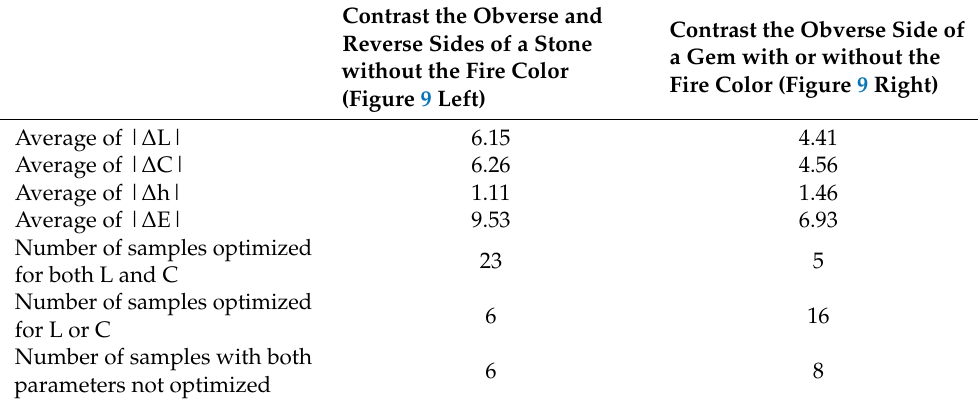
Figure 11. Tsavorites’ color grading is divided into: deep, vivid, intense, fancy, light and faint. Color rating: intense > vivid > fancy > light > deep = faint. Table 1. Comparison between before and after two kinds of cutting (overall cutting and small facet cutting), including the color difference and the optimized samples’